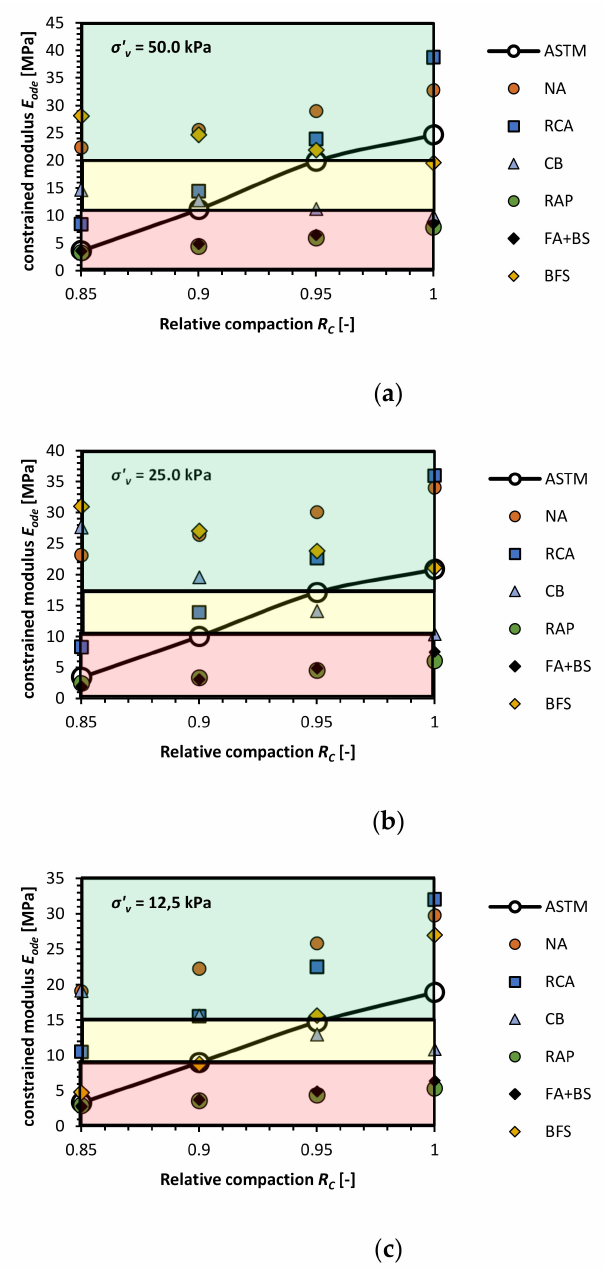
Figure 9. Constrained modulus value versus effective vertical stress at distinct stress levels for NA and five types of AS with denoted areas of required constrained modulus value, colors indicate: green-zone of fulfilled E ode modulus requirement; yellow-moderate zone, where the constrained modulus is in the range of requirements; red-zone in which the E ode do not meet pipe fill requirements, ( a ) σ ’ v = 50.0 kPa, ( b ) σ ’ v = 25.0 kPa, ( c ) σ ’ v = 12.5